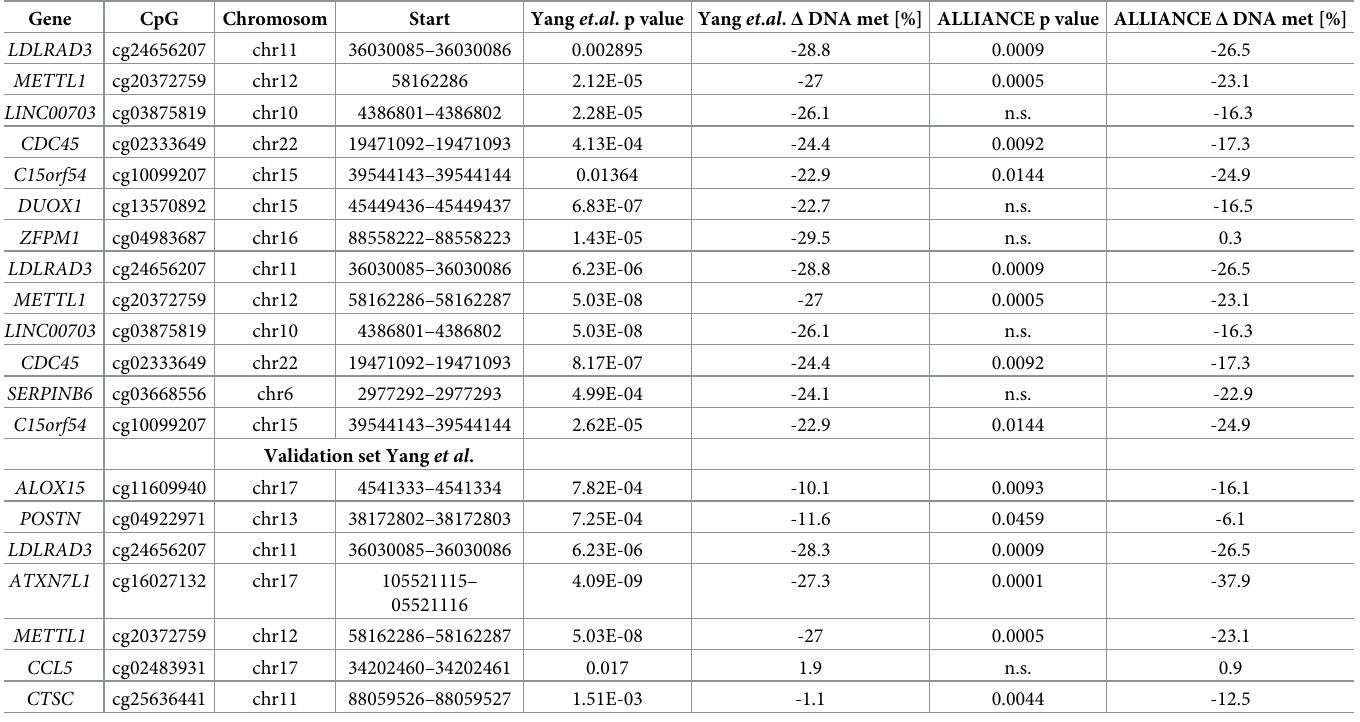
Table 5. Comparison of asthma-specific CpGs within the ALLIANCE dataset with the Inner City Asthma Consortium. Gene